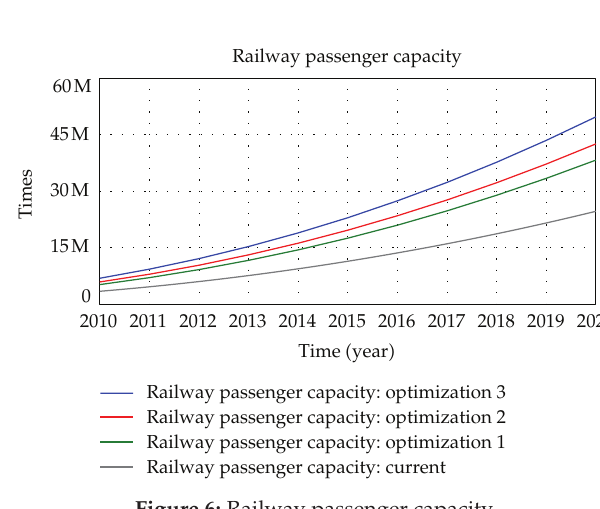
Figure 5: Public transport share rate.